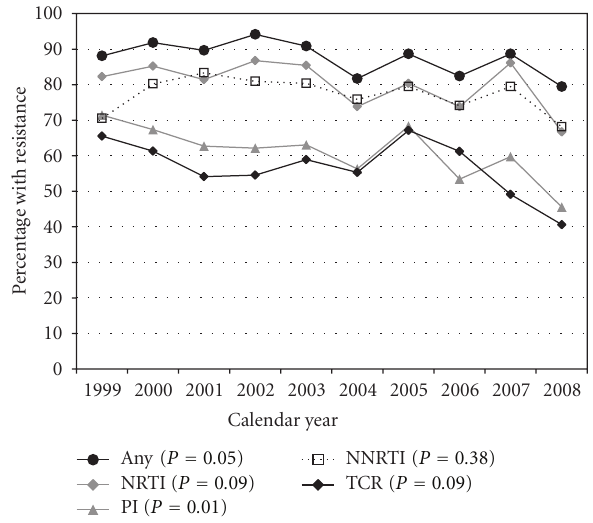
Figure 4: Frequency of genotypic resistance by class of antiretro- viral, among exposed patients, in the HIV Outpatient Study, 1999–